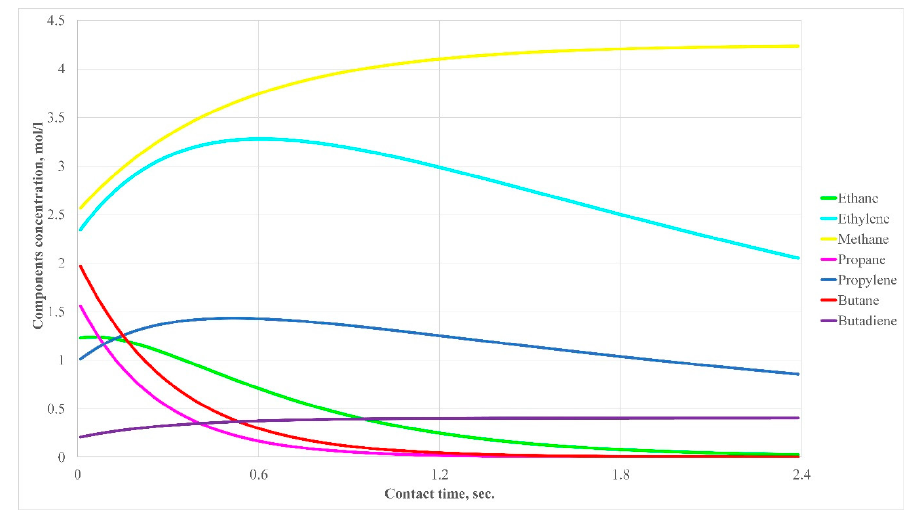
Figure 7. Change in the concentration of components with an increased contact time.